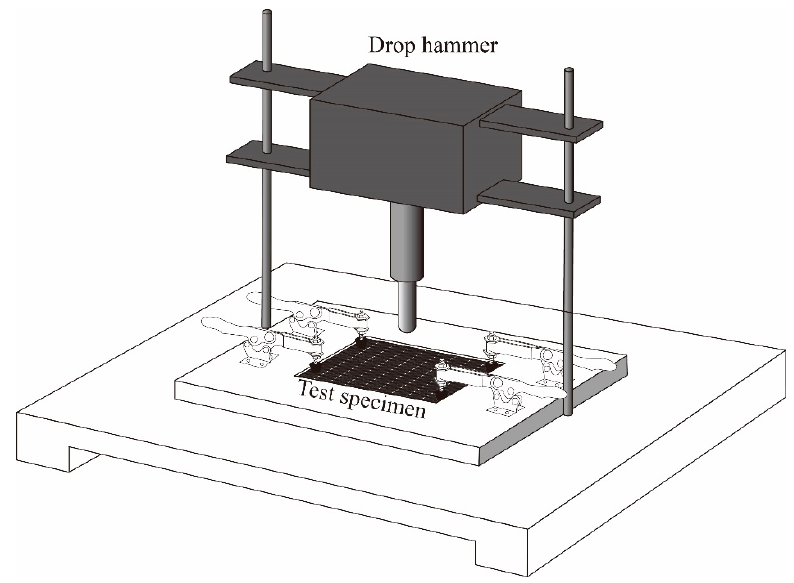
Figure 13. Schematic of low velocity impact test.